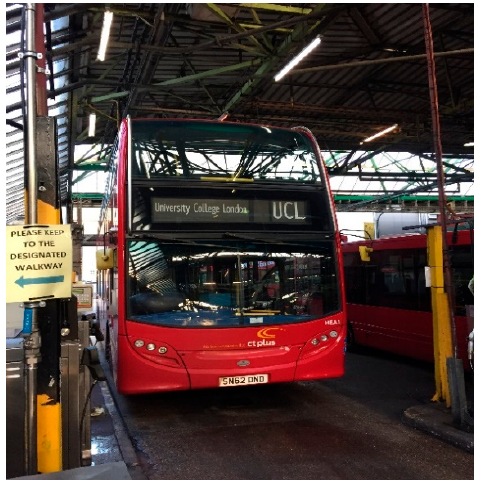
Figure 2. UCL diesel electric hybrid bus for data collection.